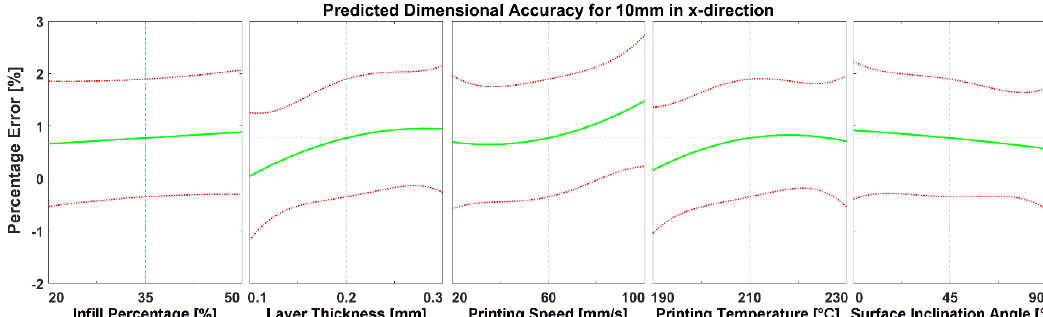
Figure 6. Predicted effects of changes in process parameters on the error% for dimensional accuracy of 10 mm length in the X direction. 10 mm length in the X direction.